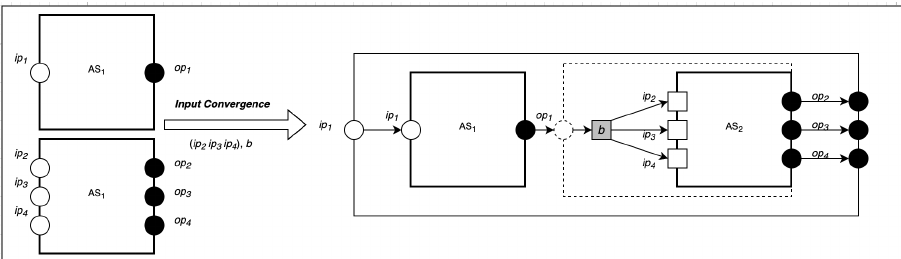
Figure 2. Input Convergence Composition.